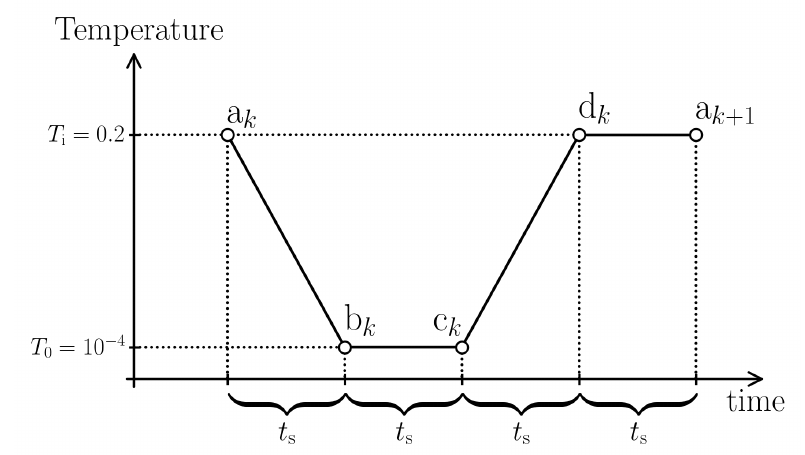
Figure 1. Schematic view of the imposed cyclic temperature variation. The letter a k denotes the initial state of the k th cycle and b k refers to the state right after cooling. c k marks the time after holding the temperature constant at T = T 0 = 10 − 4 and d k is the first instant after reheating. The cycle ends at a k + 1 after a holding step at T = T i = 0.2. Within this notation, the initial “as-aged” state, which we specify with the index i , coincides with a 1 .